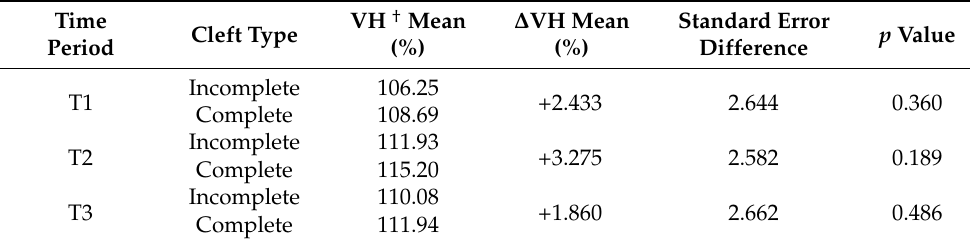
Table 3. Comparison of vermillion height means at T1, T2, and T3 between incomplete and complete cleft